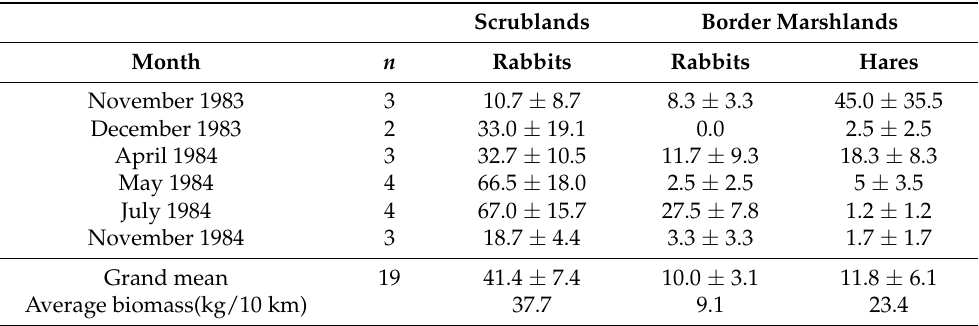
Figure 3. Habitat use by European rabbits and Iberian hares in six vegetation zones at Doñana National Park, SW Spain. Statistical t -values are indicated for each vegetation type and are provided at the top of the bars. Note that transitional zones were used by both species, whereas hares were more abundant in the marshland and rabbits in the scrubland. Table 1. Relative abundances based on roadside counts (individuals/10 km) of European rabbits and Iberian hares in two vegetation types in Doñana National Park, 1983 and 1984. Means ± SE and sample size are indicated for each